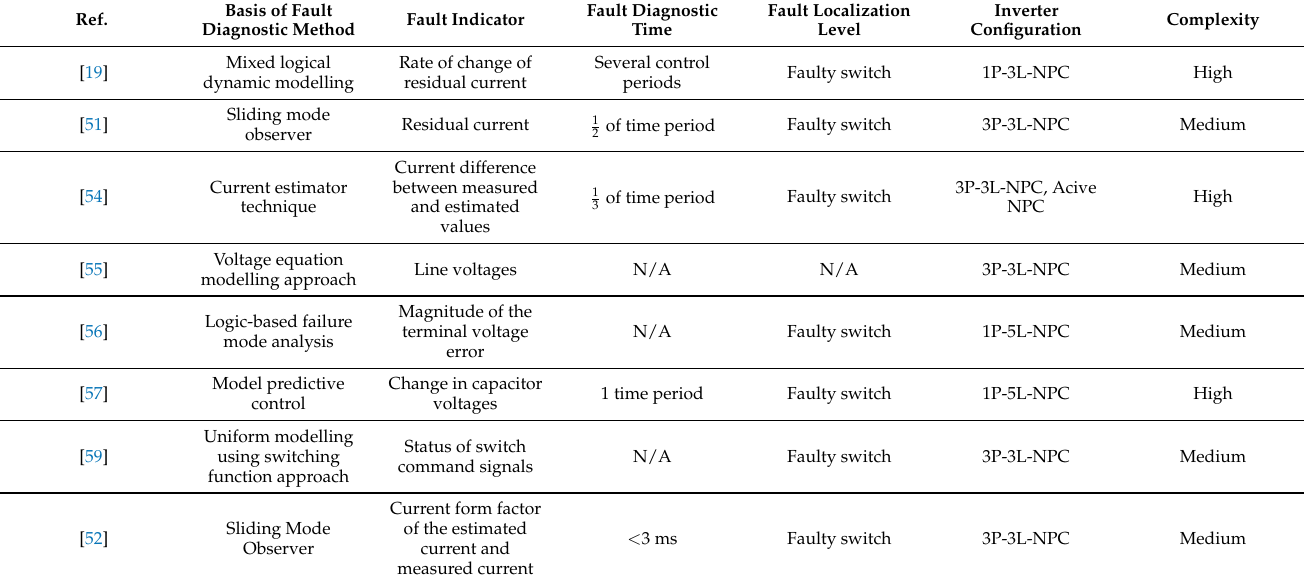
Table 4. Model based fault diagnostic